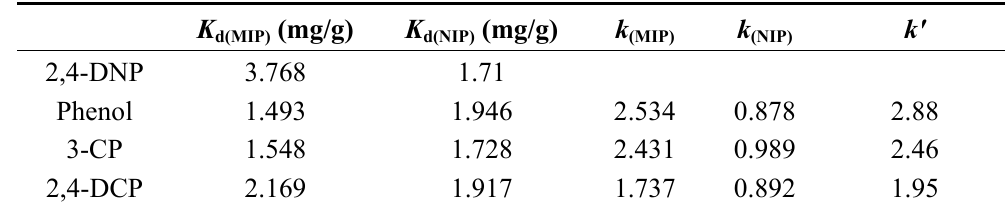
Table 2. Parameters involved in the selectivity study of the MIP and NIP towards different kind of phenolic compound